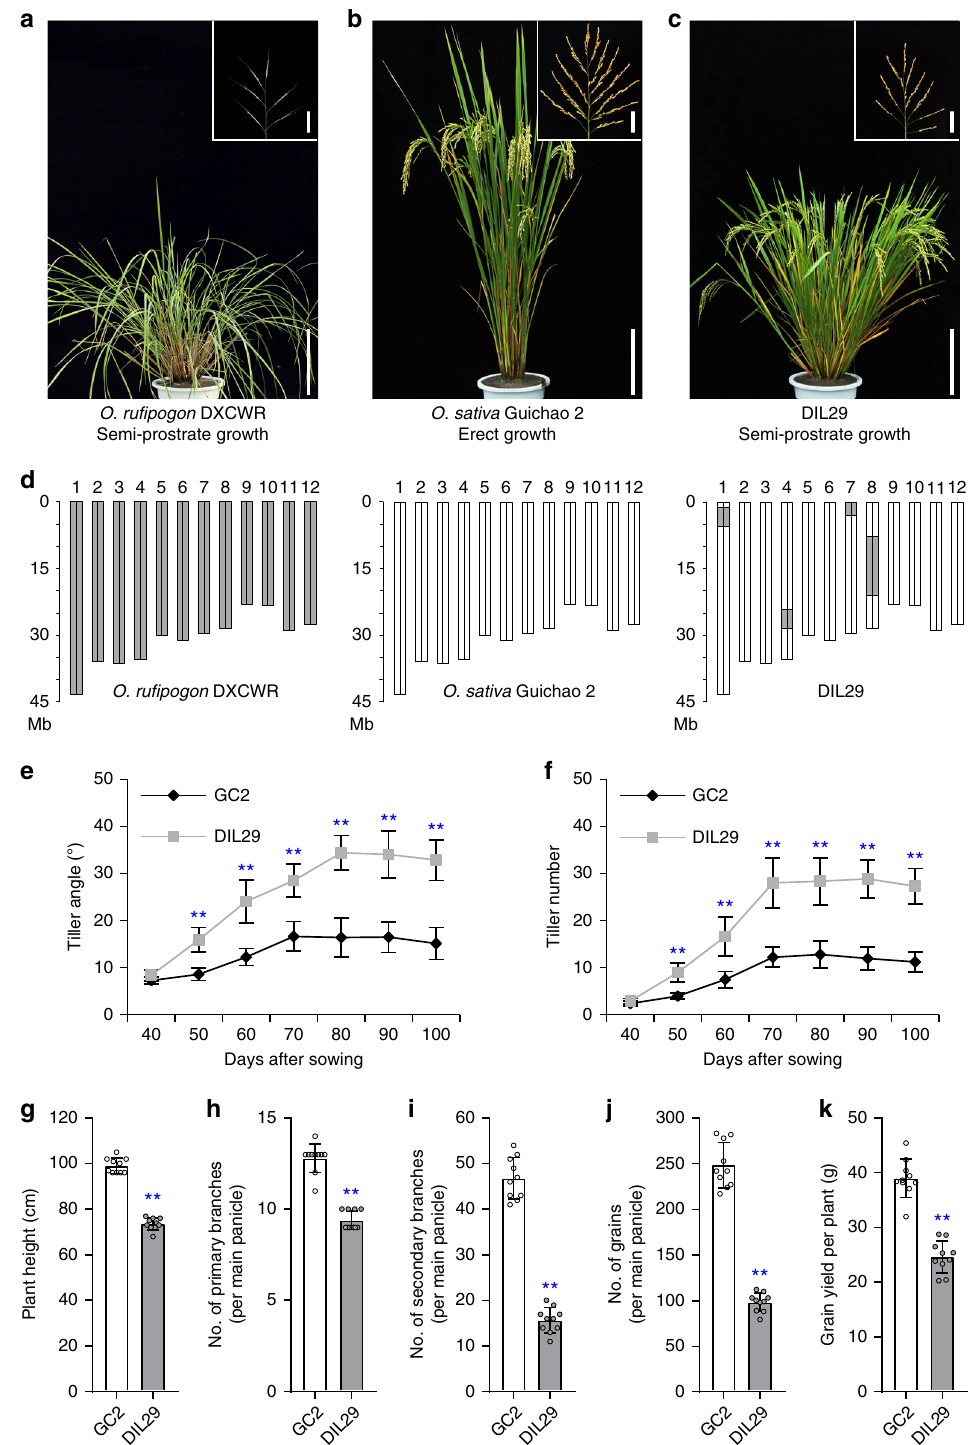
Fig. 1 Phenotypes and genotypes. a – c Phenotypes of O . ru fi pogon accession DXCWR, indica variety Guichao 2 (GC2), and the introgression line DIL29, respectively. Panicles of DXCWR, GC2, and DIL29 are illustrated in the respective upper right corners. Scale bars, 20 cm (plant) and 5 cm (panicle). d Graphical genotypes. The gray regions indicate the regions that are homozygous for the DXCWR genome. The white regions indicate the regions that are homozygous for the GC2 genome. e , f Comparison of tiller angle and tiller number of GC2 and DIL29 at different developmental stages. g – k Comparison of plant height, number of primary branches, number of secondary branches and grain number on the main panicle, and grain yield per plant in GC2 and DIL29. Data are means ( n = 10), with error bars showing standard deviation. Two-tailed Student ’ s t tests were performed between GC2 and DIL29 ( ** P <